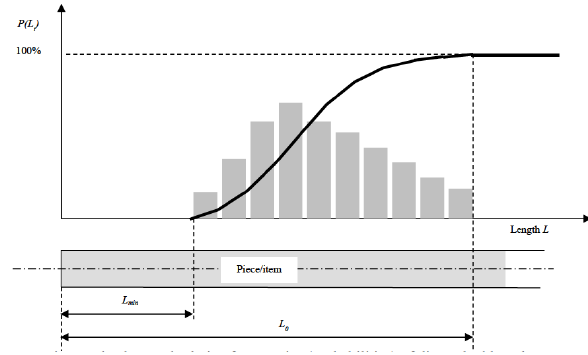
Figure 1: Absolute and relative frequencies (probabilities) of dis- patched lengths.